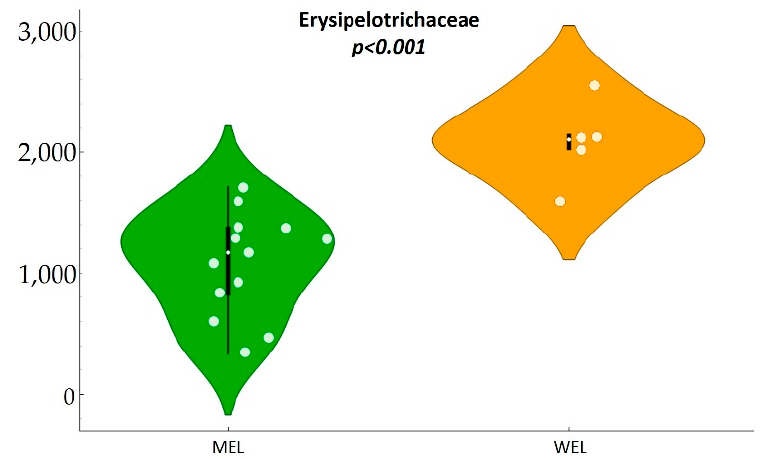
Figure 7. Erypelotrichaceae by dietary pattern in MSM.